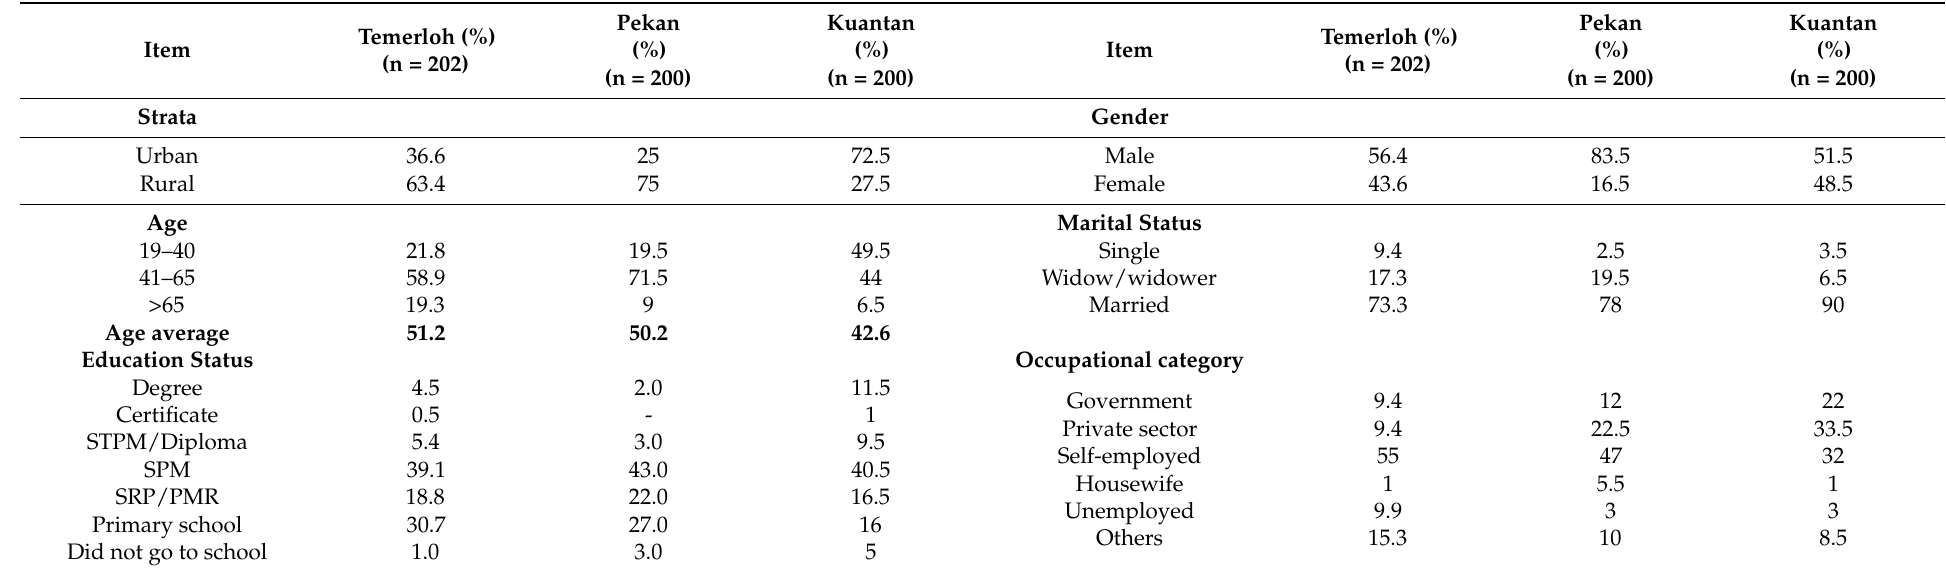
Table 3. Respondents profiling. Source: Author analysis,